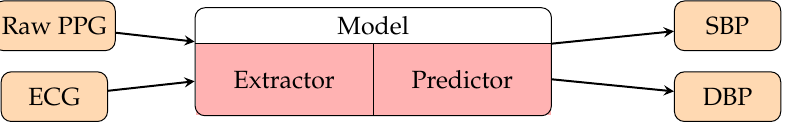
Figure 12. The flowchart of general PTT-based DL methods adopted in [132,140,142,143,146]. After preprocessing, PPG and ECG signals are fed into the models, which automatically extract the relevant features from the input signals and predict SBP and